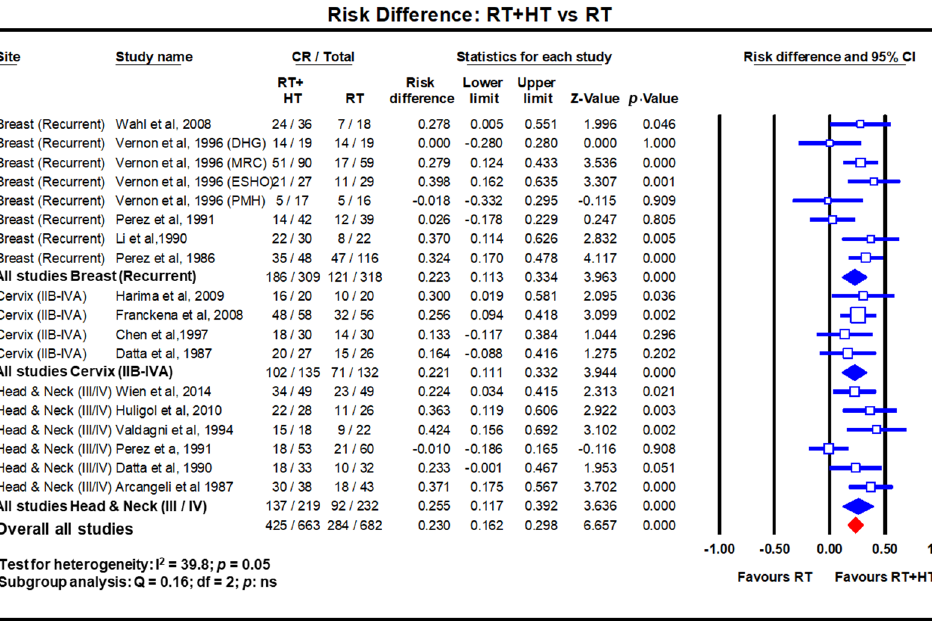
Figure 2. Forest plots depicting the risk difference for complete response with radiotherapy (RT) with hyperthermia (HT) versus RT alone in recurrent breast cancers, locally advanced cervical can- cer (stages IIB-IVA) and locally advanced head and neck cancers (stages III/IV). Data extracted from Datta et al. [14,18,19] and replotted. Addition of hyperthermia to radiotherapy favours the outcome compared to radiotherapy alone in all sites with a risk difference of 23% ( p < 0.001). (Q test: test for heterogeneity; df: degree of freedom and ns: not significant). For citations of the studies listed, please refer to [14,18,19].